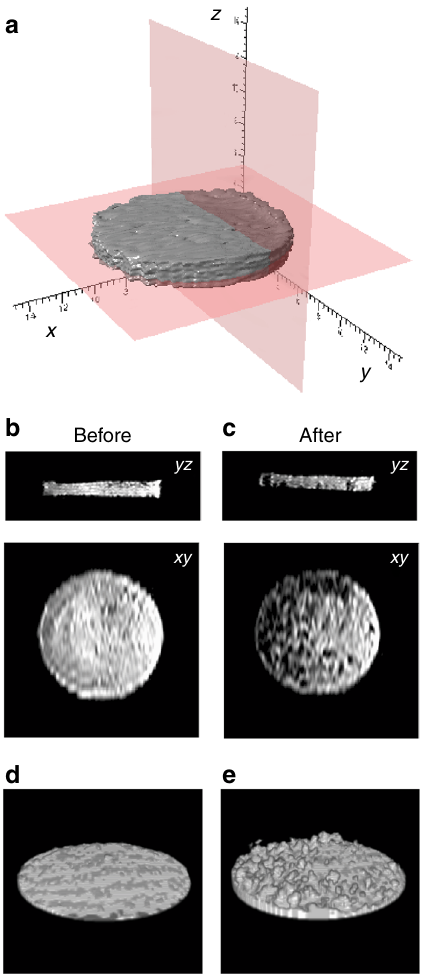
Fig. 4 1 H MRI of electrolyte signal before and after galvanostatic plating of the working electrode. a 3D surface rendering from 1 H MRI of electrolyte in the separators before plating. The labelled red planes indicate selected 2D imaging slices from inside the cell. The vertical slice ( yz ) is at the centre of the separator stack and the horizontal slice ( xy ) is immediately above the carbon WE. Image slices are shown in columns b before and c after plating. Negative space images from 3D 1 H MRI of electrolyte d before and e after galvanostatic